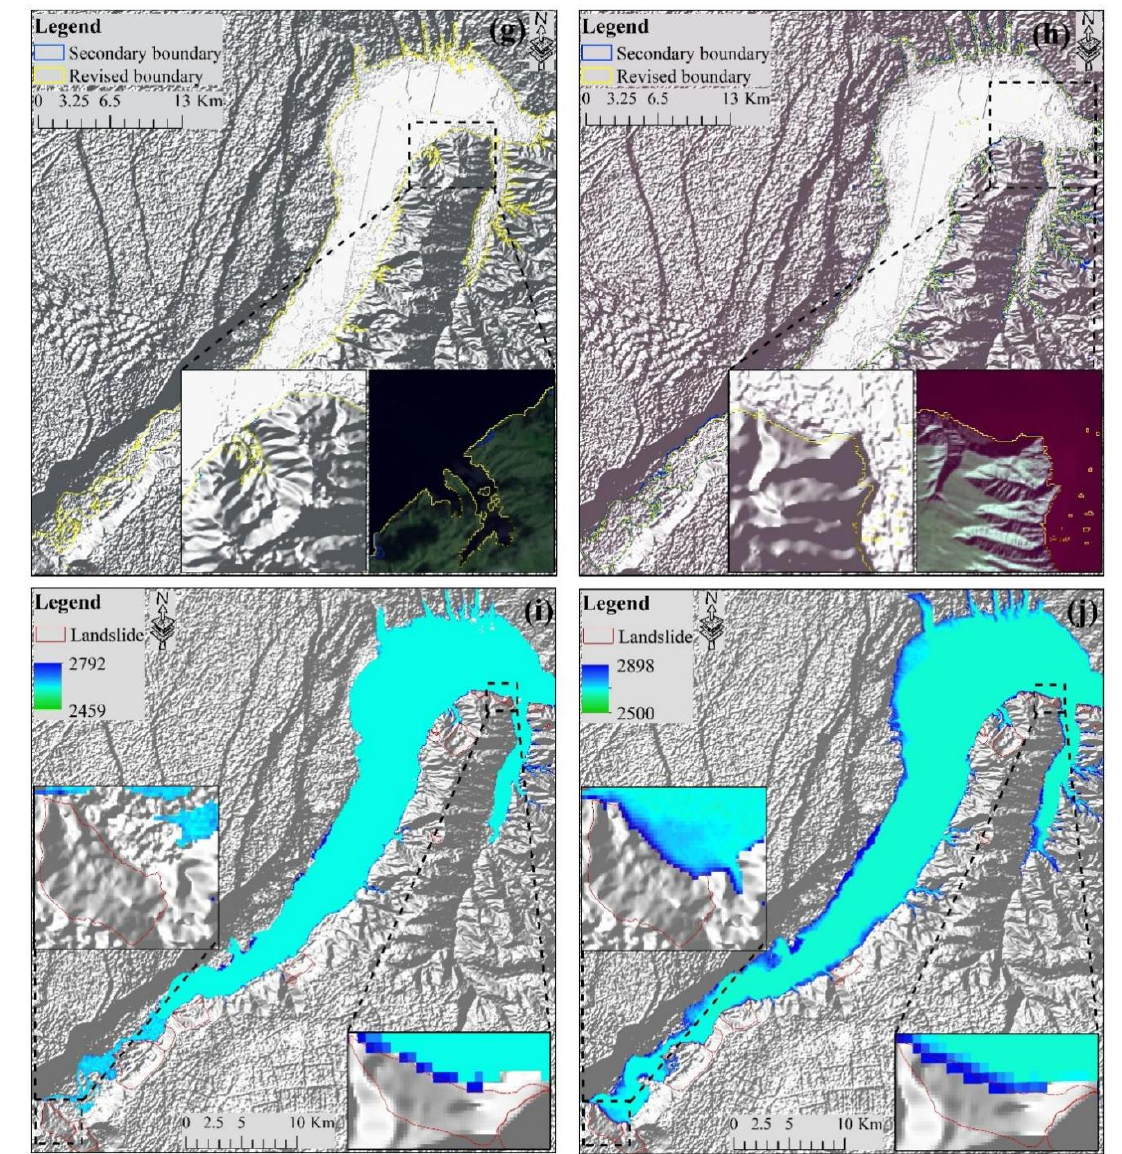
Figure 6. Using NDWI to extract the water level of Longyangxia Reservoir, taking 16 July 2017 and 26 October 2019 as examples. ( a ) False color Landsat image on 16 July 2017; ( b ) False color Landsat image on 26 October 2019; ( c ) NDWI binarized image on 16 July 2017; ( d ) NDWI binarized image on 26 October 2019; ( e ) Water body boundaries under different segmentation thresholds on 16 July 2017; ( f ) Water bodies under different segmentation thresholds on 26 October 2019; ( g ) DEM shadow modeling to remove the water body that was erroneously extracted from the water body boundary on 16 July 2017; ( h ) DEM shadow modeling to remove the water body that was erroneously extracted from the water body boundary on 26 October 2019; ( i ) Water body boundary clipping DEM and specific slope water level data on 16 July 2017; ( j ) Water body boundary clipping DEM and specific slope water level data on 26 October 2019. Table 4. Water levels of Chaxi, Chana, and Manla River Estuary landslides in the Longyangxia res- ervoir area.